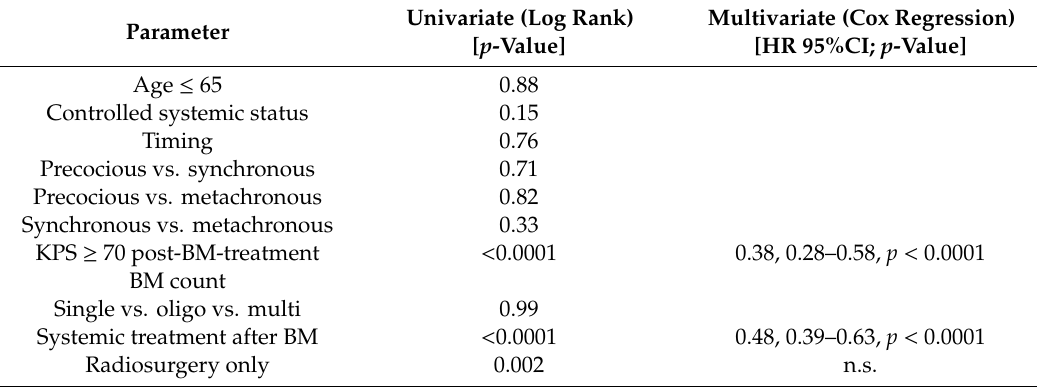
Table 2. Analysis of prognostic factors in uni- and multivariate